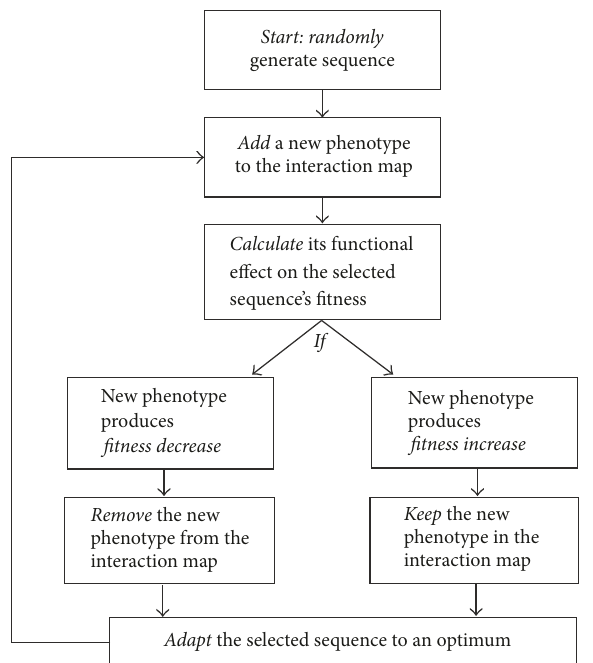
Figure 1: Schematic of the selective phenome growth algorithm: a flowchart representing the algorithm used in the selective phenome growth of interaction matrices. The scheme is similar to that used by Altenberg